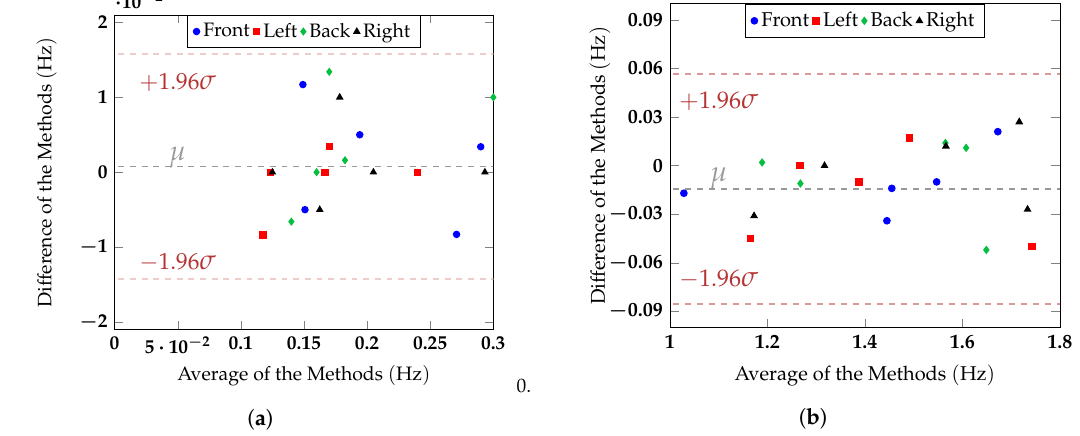
Figure 13. Bland–Altman comparison ( a ) of the respiration rate measured with the respiratory belt and the radar and ( b ) of the heart rate measured with the PPG and the radar. The grey line in the figures refers to the mean ( µ ), while the red lines define the limits of the confidence interval ( µ